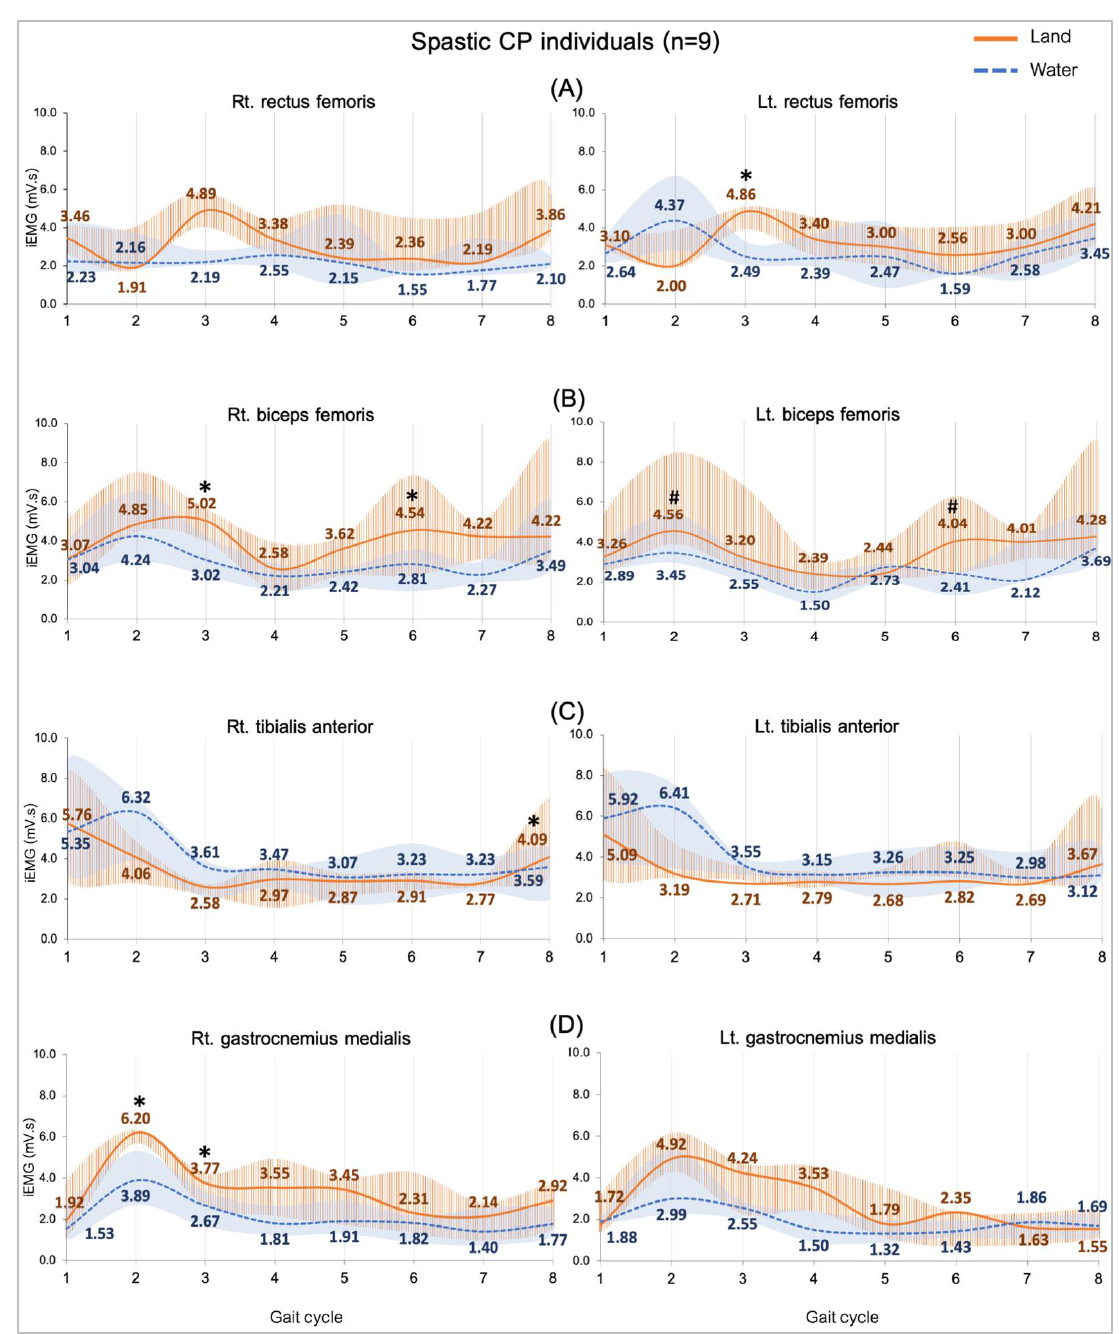
Figure 3. EMG activity while walking on land and in water in the spastic CP individuals (n = 9). Rectus femoris, RF ( A ), biceps femoris, BF ( B ), tibialis anterior, TA ( C ), and gastrocnemius medialis, GM ( D ). Gait phases: 1 = initial contact, 2 = loading response, 3 = mid stance, 4 = terminal stance, 5 = pre swing, 6 = initial swing, 7 = mid swing and 8 = terminal swing. * and # are significant median differences between walking on land and in water at p < 0.05 and p <